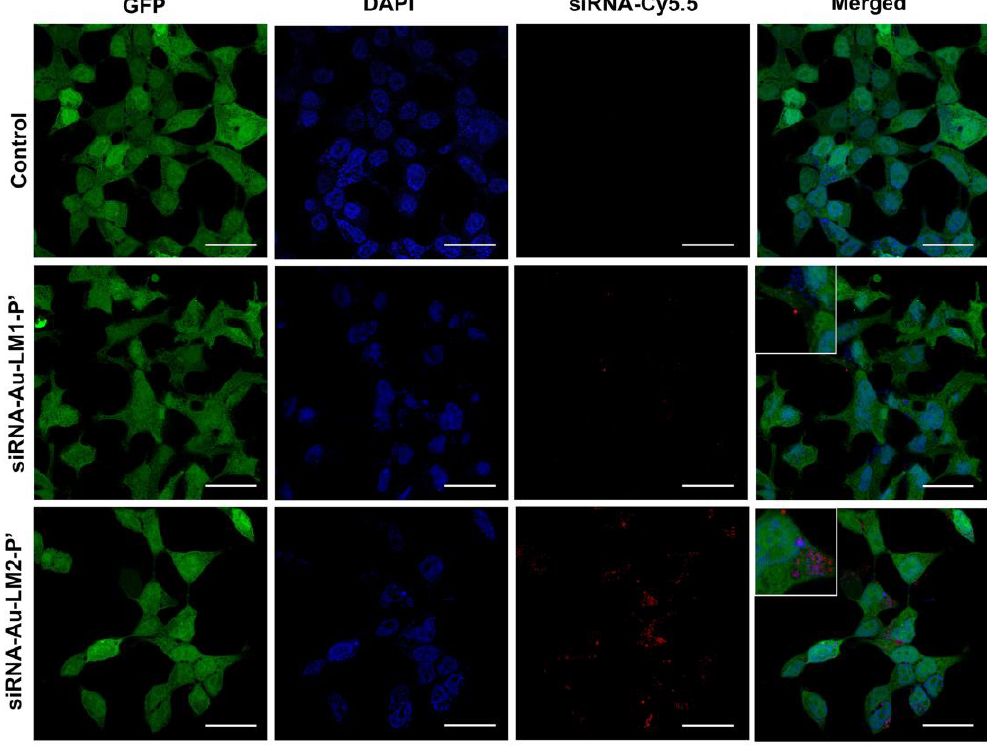
Figure 10. Uptake of siRNA-Au-LM1-P’ and siRNA-Au-LM2-P’ nanoconstructions by HEK Phoenix cells. siRNA was labeled with Cy5.5 and observed as red spots. Nuclei were stained blue with DAPI and green GFP was diffusely located inside whole cells. In the merged image, location of siRNA in cytoplasm was shown (red spots). Length of scale bars correspond to 20 µm.